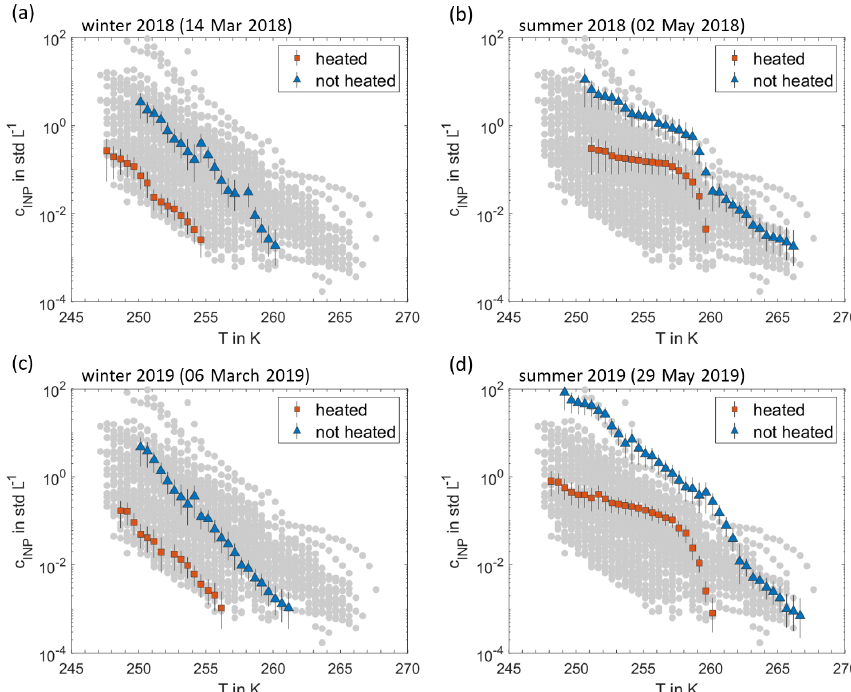
Figure 6. Effect of heat treatments. INP temperature spectra of the non-heated aerosol samples (blue triangles) are compared to the spectra of the heat-treated samples (red squares). Examples of 2d in 2018, typical for winter and summer (a, b) , and 2d in 2019, also typical for winter and summer (c, d) , are shown. In each panel, the grey dots display the entirety of non-heated and heat-treated